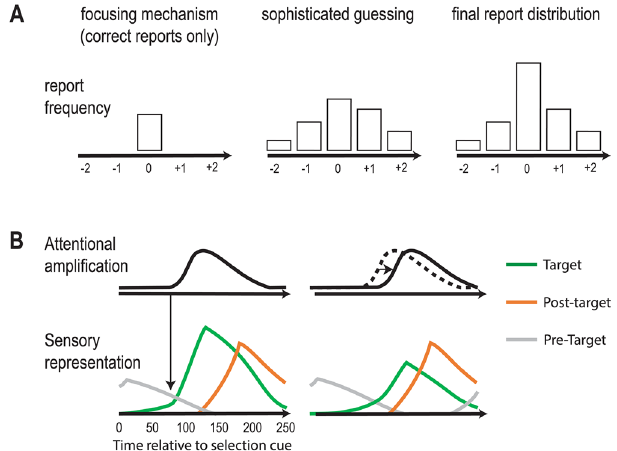
Figure 2. Two accounts of distractor intrusions. ( A ) The selection failure account suggests that two mechanisms underlie response selection in RSVP paradigms: (1) a focusing mechanism that produces